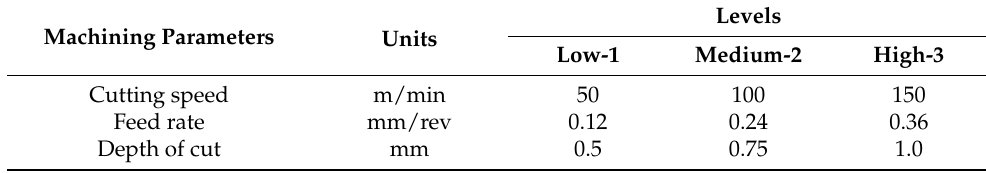
Table 1. Machining parameters used during machining of the RZ5/8 wt.% TiB 2 composite. Machining